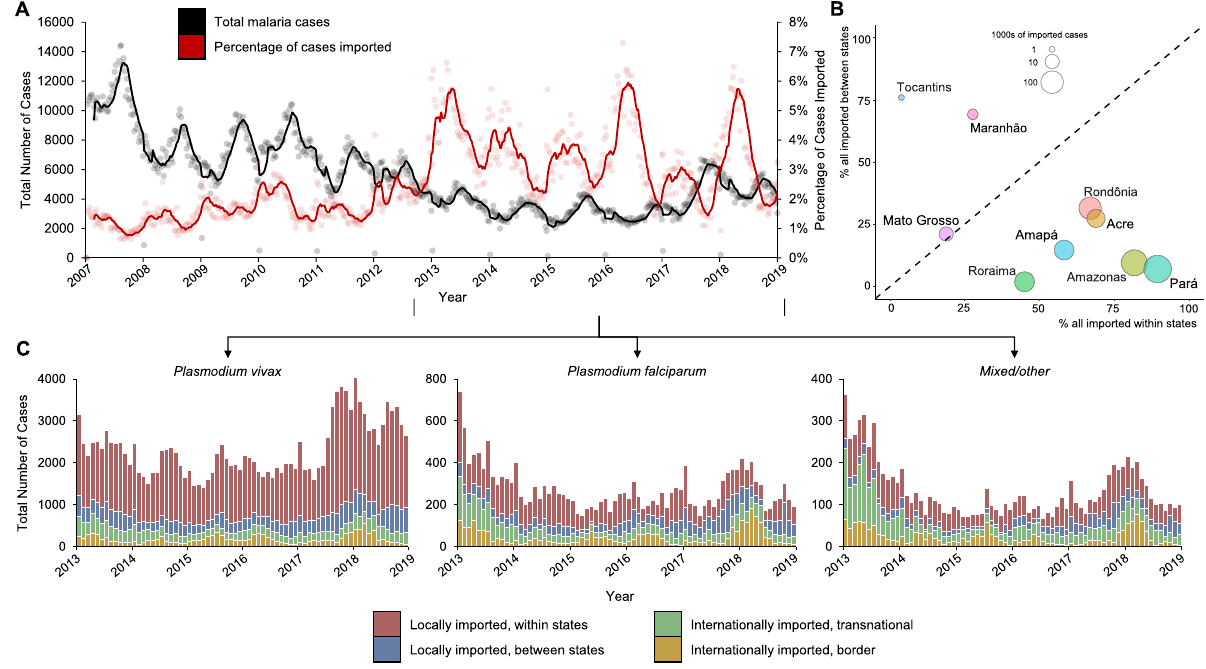
averages of cases. ( B ) Bivariate plot of percentage of all imported cases occurring within and between states, with bubble size corresponding to the total number of imported cases in each state from 2007 to 2018. ( C ) Species and importation type breakdown of cases between 2013 and 2018. Bars are monthly